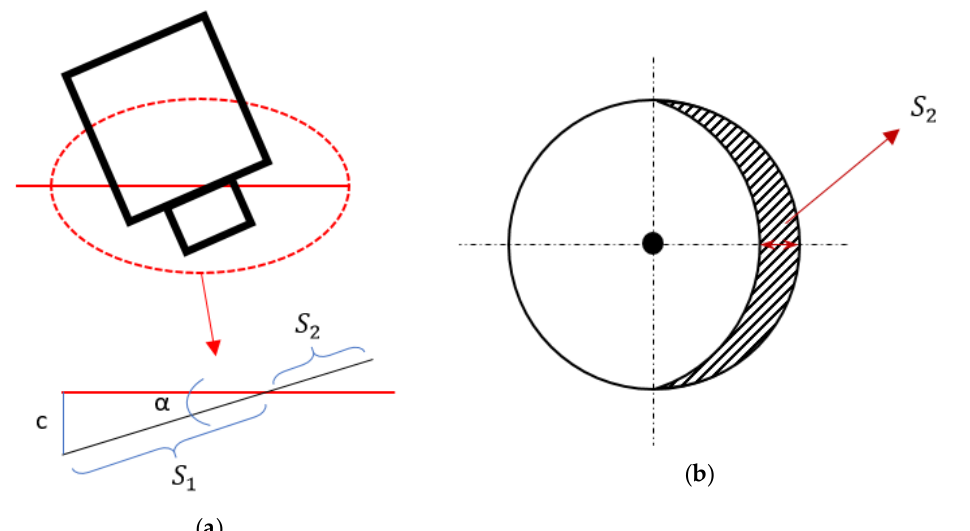
Figure 3. Schematic view of the tilt angle in ( a ) X-Y and ( b ) X-Z surfaces, c is the penetration depth of the trailing edge of the shoulder, α is the tool tilt angle, S 1 is the part of the shoulder, which is in contact with the workpiece, and S 2 is the part of the shoulder which is outside of the contact area. 𝑆𝑆 2 (the diameter of both circles is the same as the shoulder) is added in the left side of the contact area (red circle). Therefore, an additional S 2 will be added to the left side of the contact area.